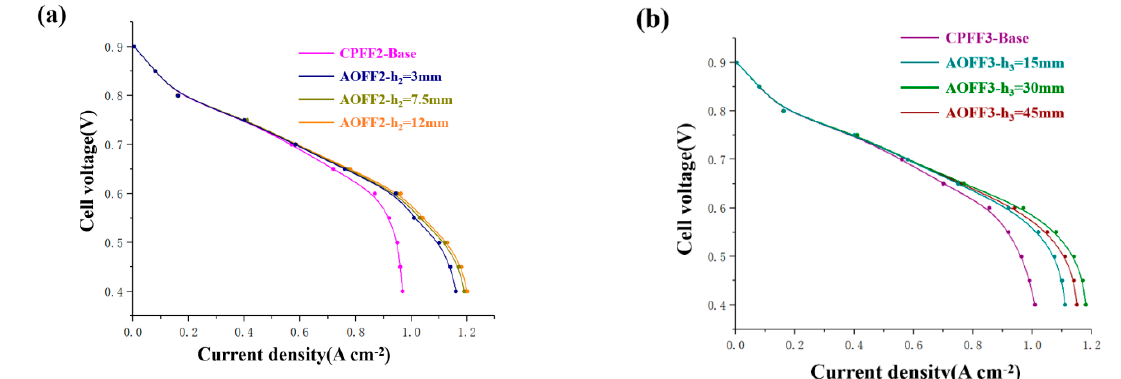
Figure 10. Performance comparison between the CPFF2 pattern and AOFF3 patterns: polarization curves and power density curves. ( a ) The proportion is 4.5 cm 2 ( b ) The proportion is 18 cm 2 .